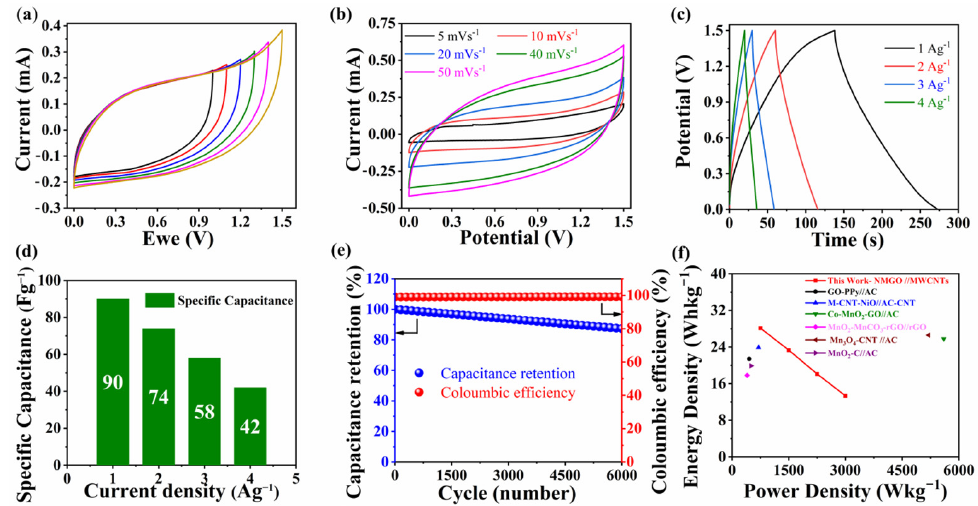
Figure 6. ( a ) CV curve of NMGO//MWCNT device at scan rate of 20 mVs − 1 for different potential window; ( b ) cyclic voltammogram of the asymmetric device at different scan rates with fixed potential window; ( c ) GCD graph of asymmetric device at different current densities; ( d ) specific capacitance of NMGO//MWCNTs asymmetric device; ( e ) comparison between coloumbic efficiency and ca- pacitance retention of asymmetric device; ( f ) Ragone plot of NMGO//MWCNT asymmetric device (this work), GO-PPy//AC [48], CNT-NiO//AC-CNT [47], Co-MnO 2 -GO//AC, MnO 2 -MnCO 3 - rGO//rGO [49], Mn 3 O 4 -CNT//AC [16], and MnO 2 -C//AC